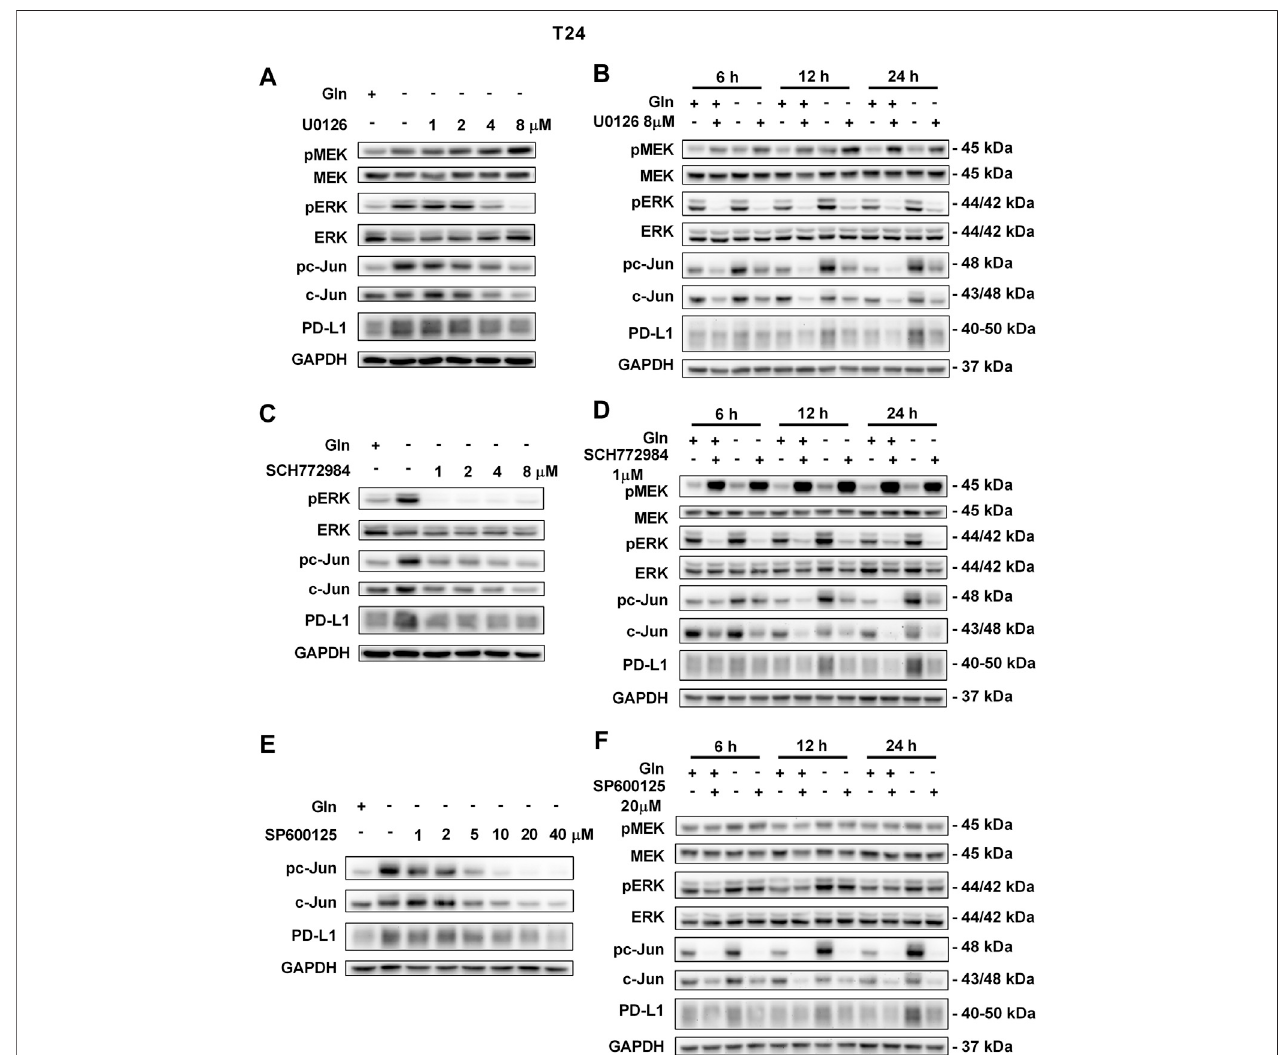
FIGURE4| InhibitingpMEK, pERK or pc-Jun activation canreducetheelevated PD-L1 level inducedby glutamine deprivationin T24cells. (A) The protein levels of pMEK,pERK,pc-JunandPD-L1inT24cellsculturedinglutamine-freemediumwithdifferentconcentrationsofthepMEKinhibitor(U0126:0,1,2,4,and8 μ M)for24 h. (B) The protein levels of pMEK, pERK, pc-Jun and PD-L1 in T24 cells after culturing in normal or glutamine-free culture medium with the pMEK inhibitor (8 μ M) for 6, 12 and 24 h. (C) The protein levels of pERK, pc-Jun and PD-L1 in T24 cells cultured in glutamine-free medium with different concentrations of the pERK inhibitor (SCH772984: 0, 1, 2, 4, and 8 μ M) for 24 h. (D) The protein levels of pMEK, pERK, pc-Jun and PD-L1 in T24 cells after culturing in normal or glutamine-free culture medium with the pERK inhibitor (1 μ M) for 6, 12 and 24 h. (E) The protein levels of pc-Jun and PD-L1 in T24 cells cultured in glutamine-free medium with